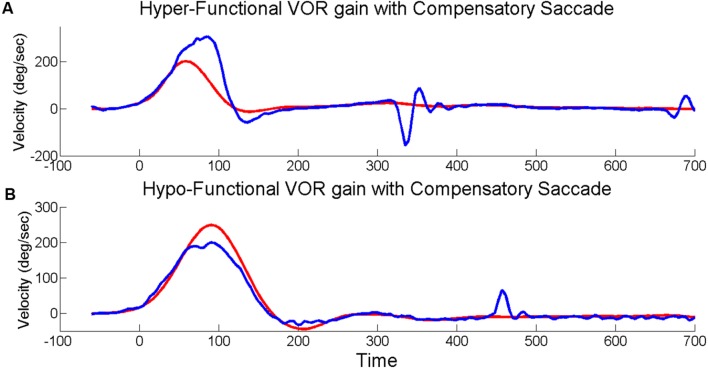
Head impulses with saccades. Exemplar vHITs showing the presence of an isolated back-up compensatory saccade with hyper-functional VOR gain (A) and compensatory saccade with hypo-functional VOR gain (B). Eye velocity (blue) has been inverted and shown superimposed on head velocity (red).